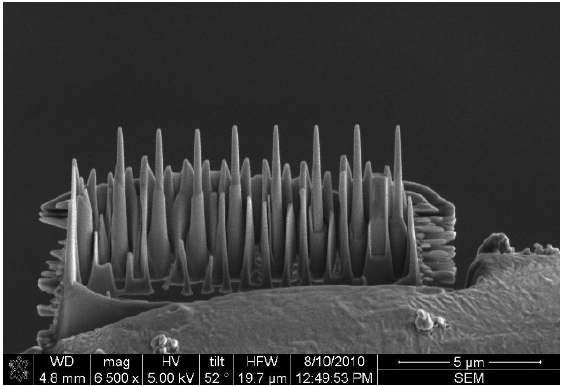
Figure 1. Zr-based metallic glass nanopillars fabricated by dual-beam focused ion beam (DB-FIB) for in situ transmission electron microscopy (TEM) compression experiments.